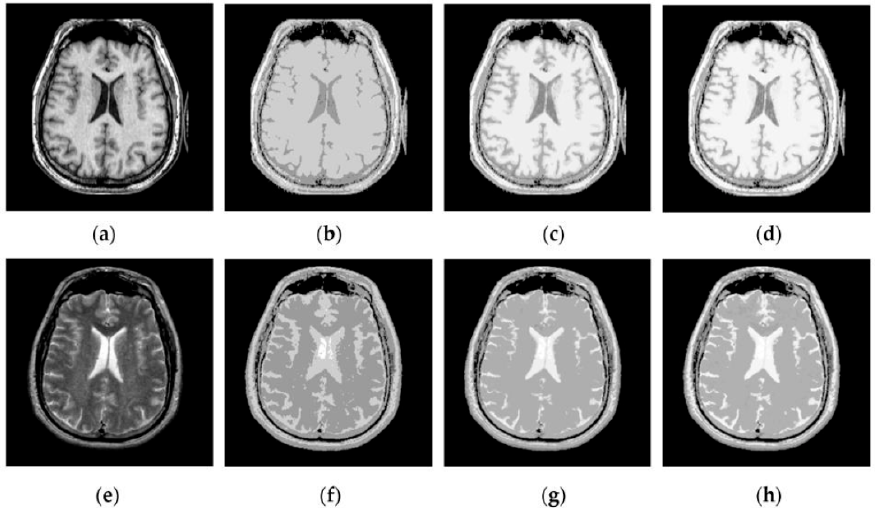
Figure 4. Firing mapping images corresponding to MR-T2 and MR-T1 images: ( a , e ) MR-T2 and MR-T1 images; ( b , f ) FMIs with N max = 10 for (a,e); ( c , g ) FMIs with N max = 30 for (a,e); and ( d , h ) FMIs with N max = 50 for (a,e).